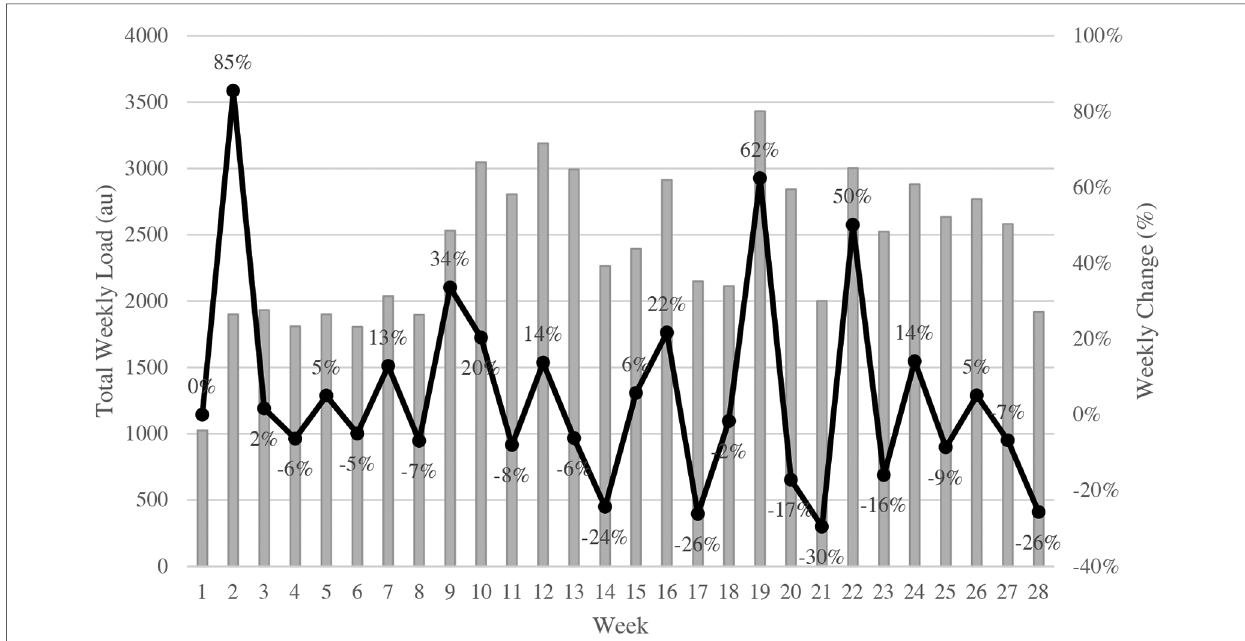
FIGURE 1 Weekly totals presented in arbitrary units (AU) combined with line graphs that represent percentage difference between weeks in collegiate female basketball players ( n =11).